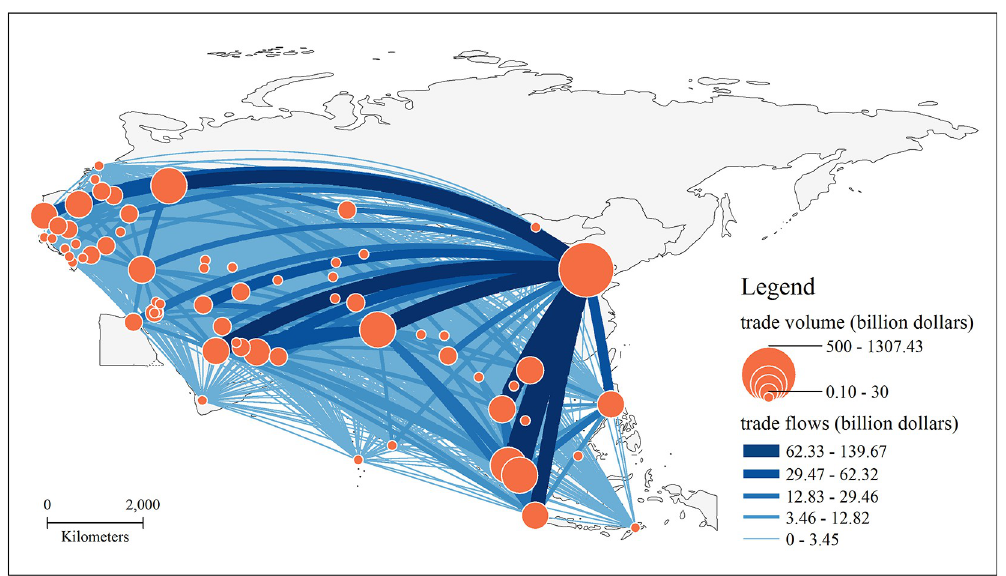
Fig 1. The trade network pattern of the BRI region. Note: The basemap used to construct the map was obtained from the following source: China Map Publishing House Co., LTD. They have been republished under a CC BY license, with permission from the China Map Publishing House Co., original copyright